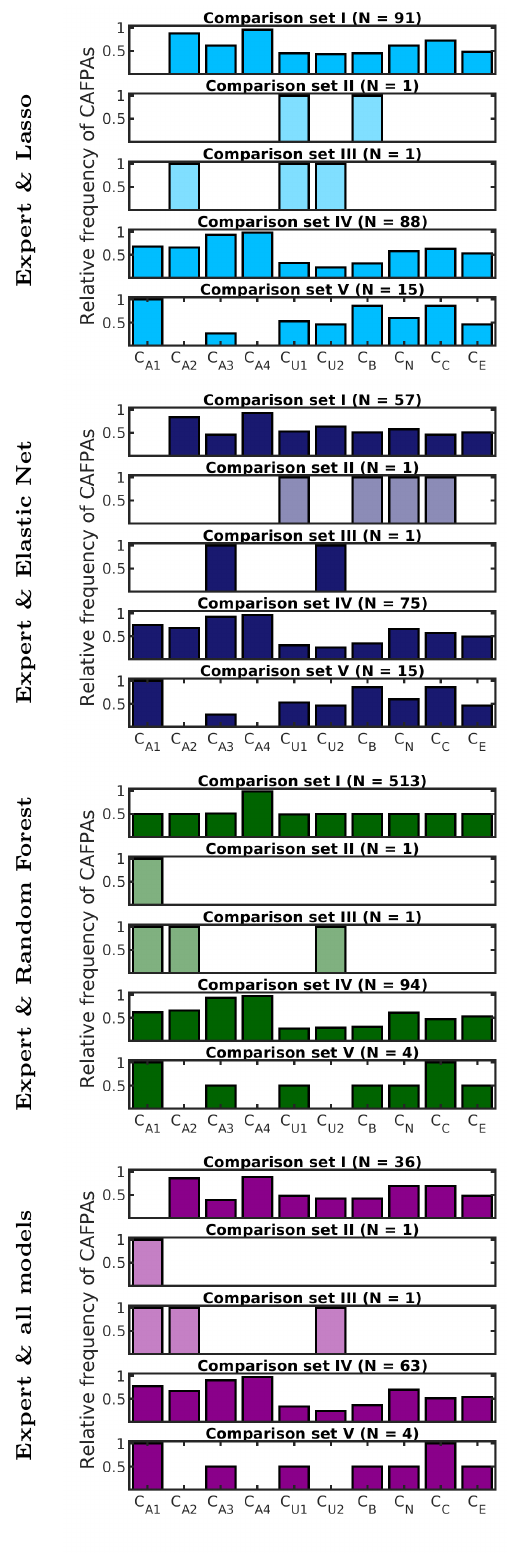
Figure 5. Relative frequency of CAFPAs included in Y90 combinations, common for expert-estimated CAFPAs and respective models (first three panels, colors for different models). The last panel (purple) shows the relative frequency of CAFPAs common to experts and all models. If no common weights were found, the best CAFPA combination of the respective model is depicted (lighter